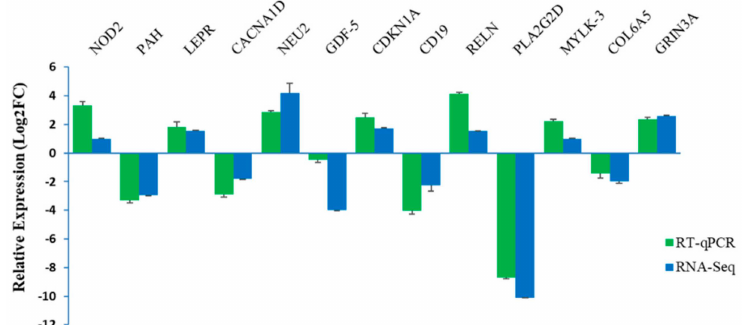
Figure 4. Comparison of gene expression levels measured using RNA-Seq and RT-qPCR. The relative expression levels of both the RT-qPCR and RNA-Seq were expressed as Log2fold change (FC), which is defined as the ratio of the expression level in the STH sheep to that in the GAM sheep for a specific gene. The expression values for the RT-qPCR are given relative to the expression levels of the β -actin and GAPDH gene. The error bars are a representation of the variation in the three separate sheep studied per